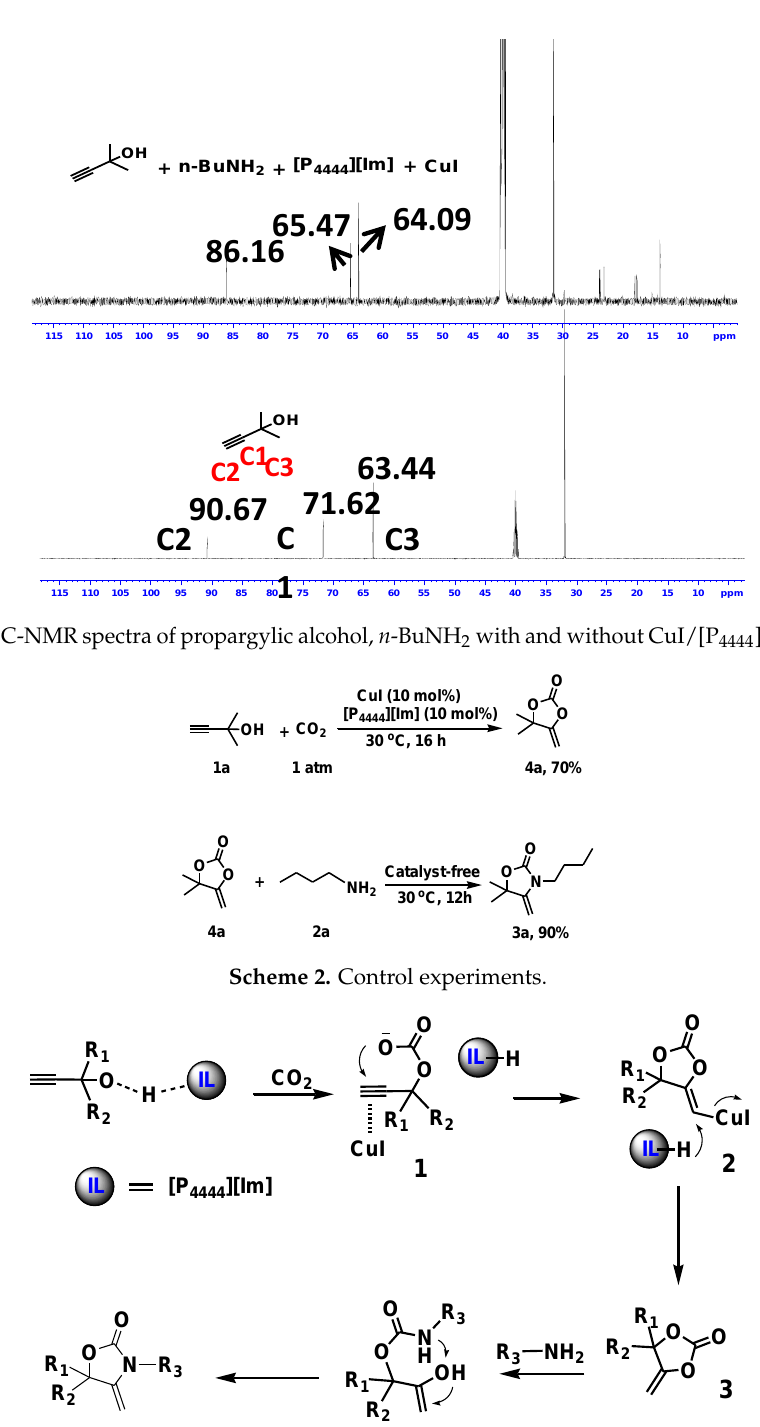
Figure 3. 1 H-NMR spectra of propargylic alcohol, n -BuNH 2 with and without CuI/[P 4444 ][Im] catalyst.